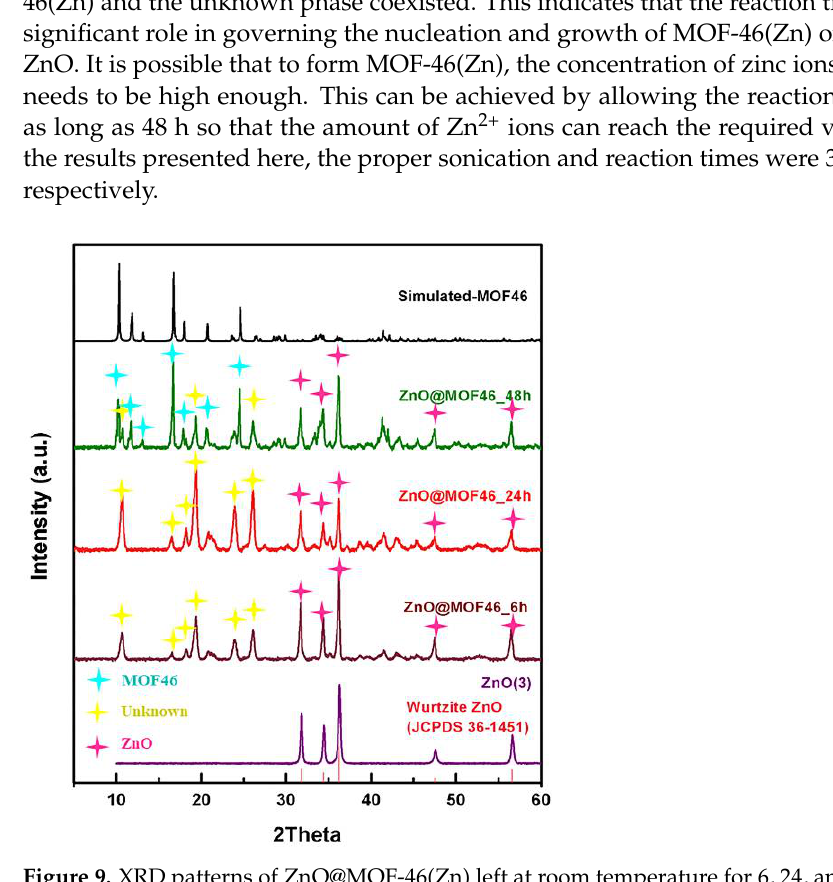
Figure 9. XRD patterns of ZnO@MOF-46(Zn) left at room temperature for 6, 24, and 48 h. The nanosheets assembled into spherical agglomerated particles regardless of soni- cation time. XRD analysis indicates that both the unknown phase and MOF-46(Zn) were produced in nanosheet form. The effect of reaction time as studied by SEM is displayed in Figure 10. The results reveal that for the composites reacted for 6 h, small nanosheets of the unknown phase with a size of approximately 0.37 nm assembled to form agglomerated particles with sizes varying from 1.9 to 3.5 nm. As the reaction time increased to 24 h, the agglomerated particles became larger in size than those produced in 6 h.